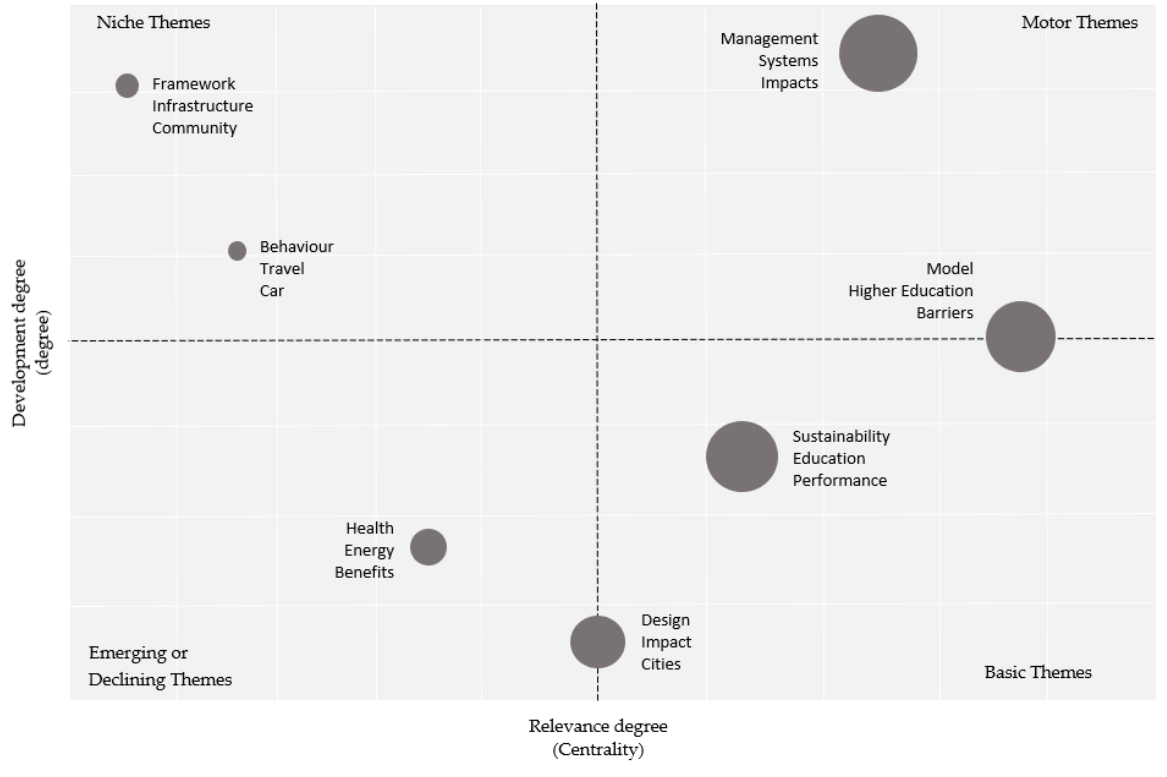
Figure 4. Key research themes’ evolution .